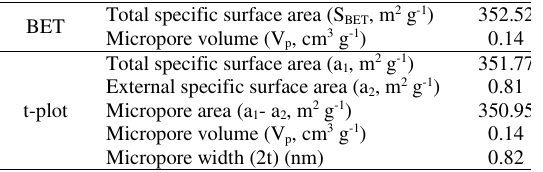
Table 2. The pore structure properties of nano LTA that were calculated from BET model and t-plots.